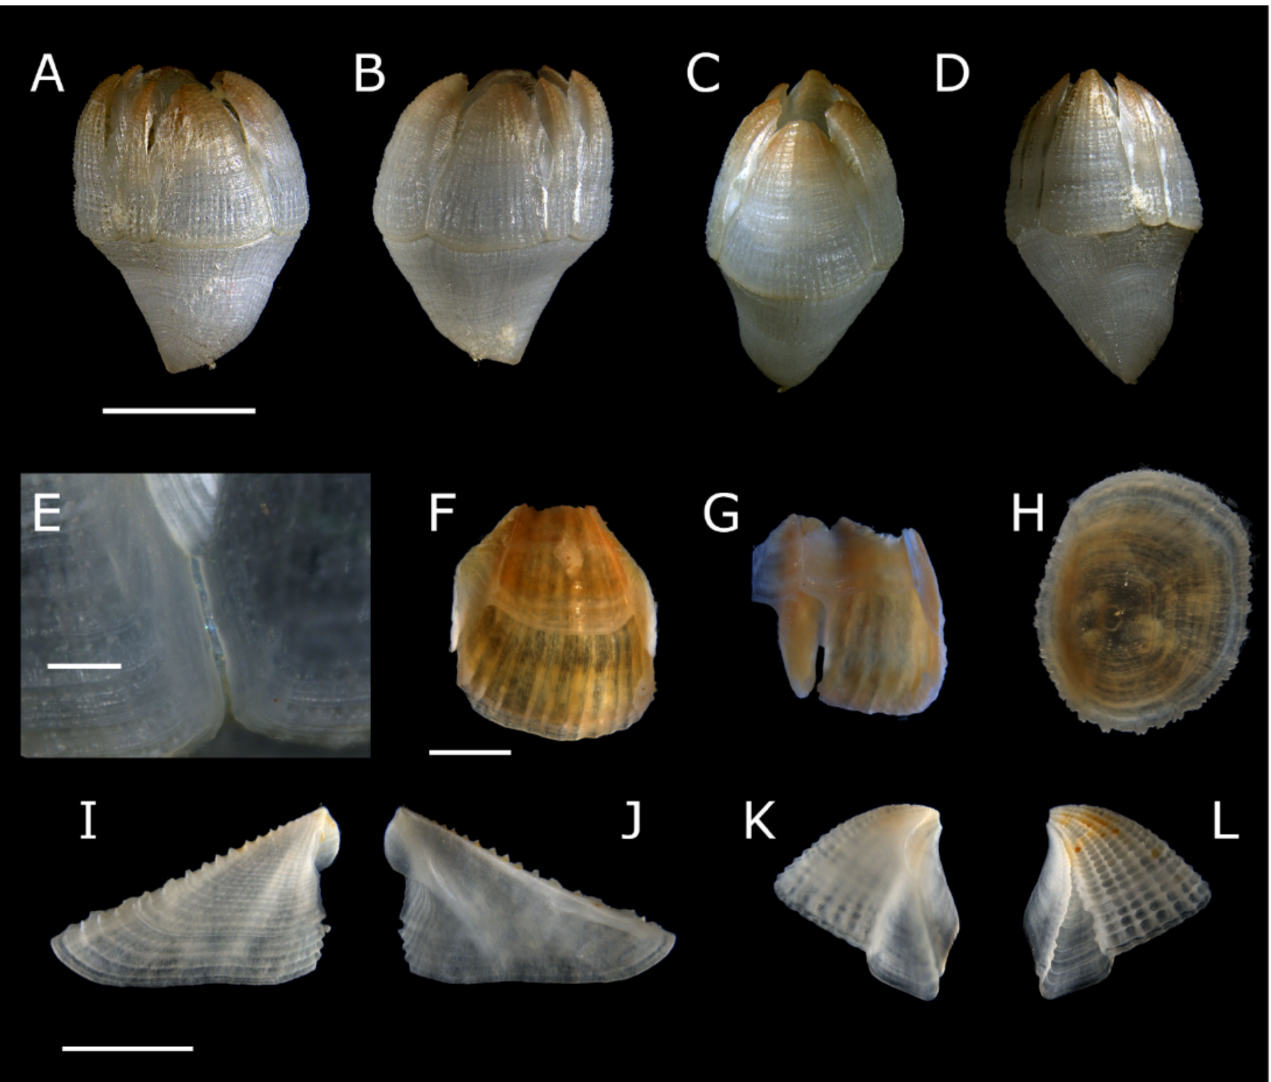
Figure 21. Pectinoacasta pectinipes (Pilsbry, 1916) shell and shell plates (A–E, I–L: WAM C67772; F–H: WAM C58870), ( A – D ) left, right, rostral and carinal views, respectively, of whole shell; ( E ) membranous slit between junction of rostrum and right lateral; ( F ) internal view of rostrum, ( G ) internal view of right lateral and carinolateral; ( H ) internal view of basis; ( I , J ) external and internal views of scutum; ( K , L ) internal and external views of tergum. Scale bars: A–D = 5 mm; E = 0.5 mm; F–H = 1 mm; I–L = 2